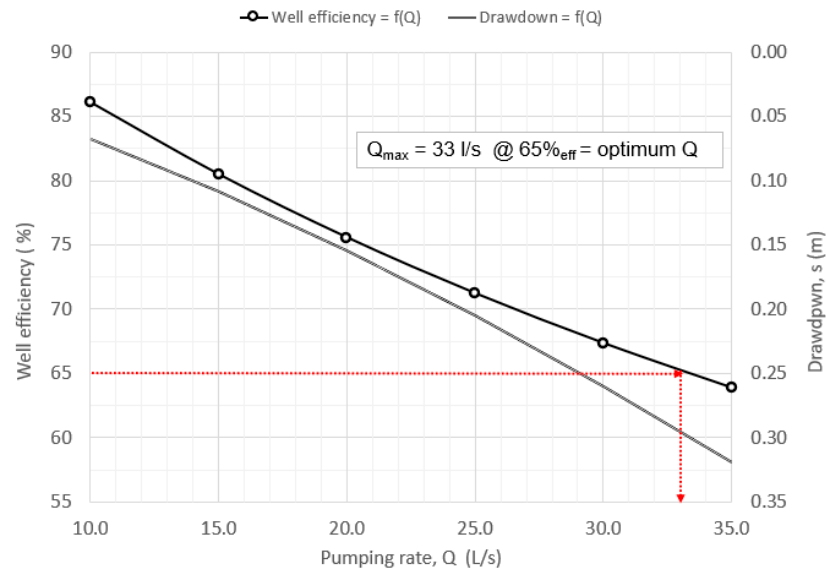
Figure 15. Determining the optimum pumping rate.